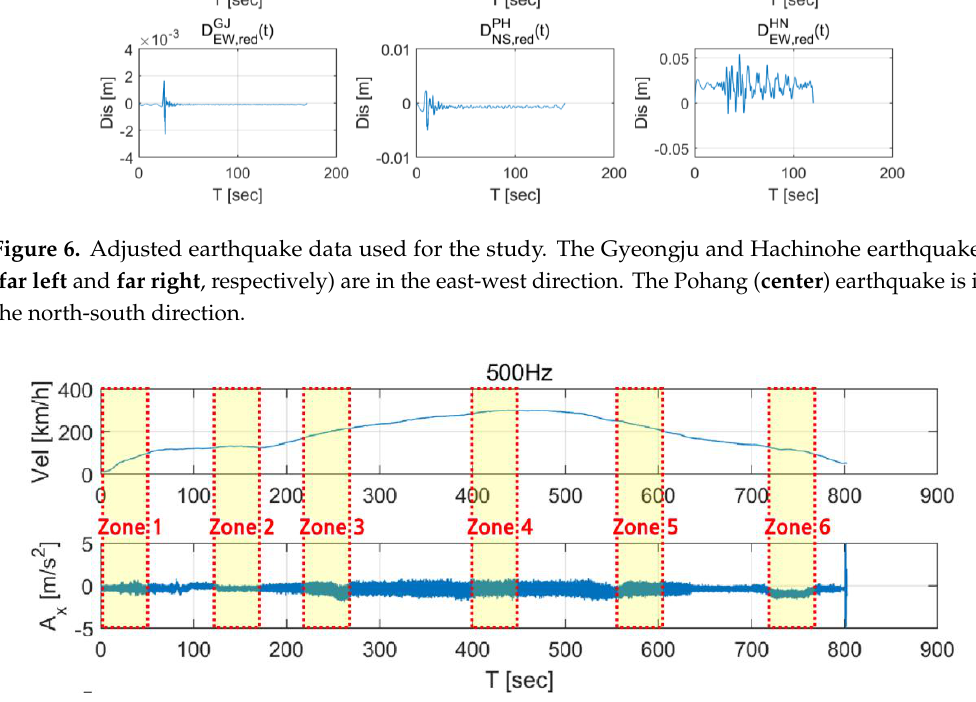
Figure 7. Zones selected from earthquake data for superimposed with train data.